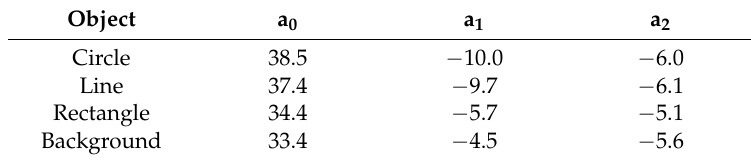
Figure 3. Simulated NDVI and LST data. The 10 m, 40 m and 100 m notations indicate the spatial resolutions of the simulated data. The 40 m and 100 m-resolution data were aggregated from the 10 m-resolution data. The image size of the 10 m-resolution data is 1000 × 1000. Table 2. Coefficients of the function relationship used in the simulated data.